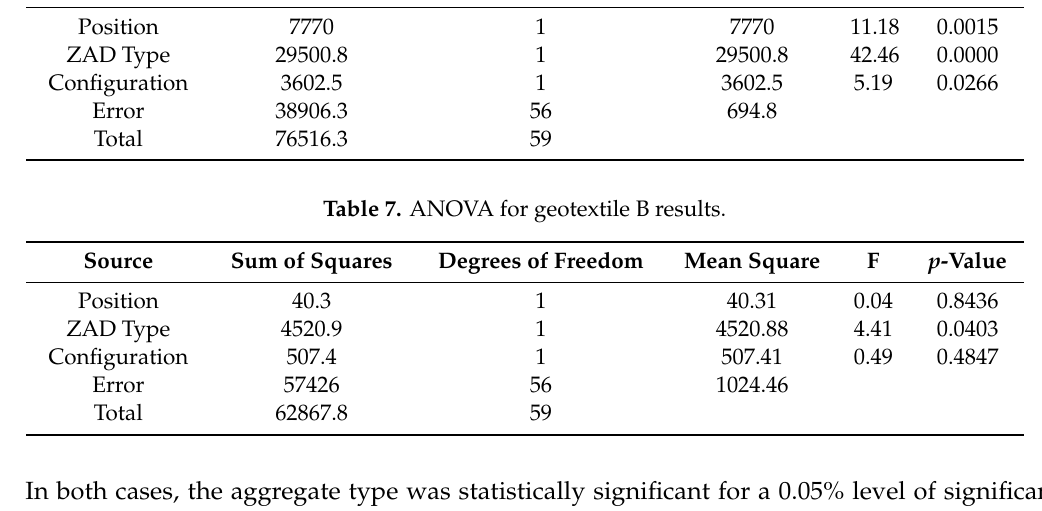
Table 6. ANOVA for geotextile A results.